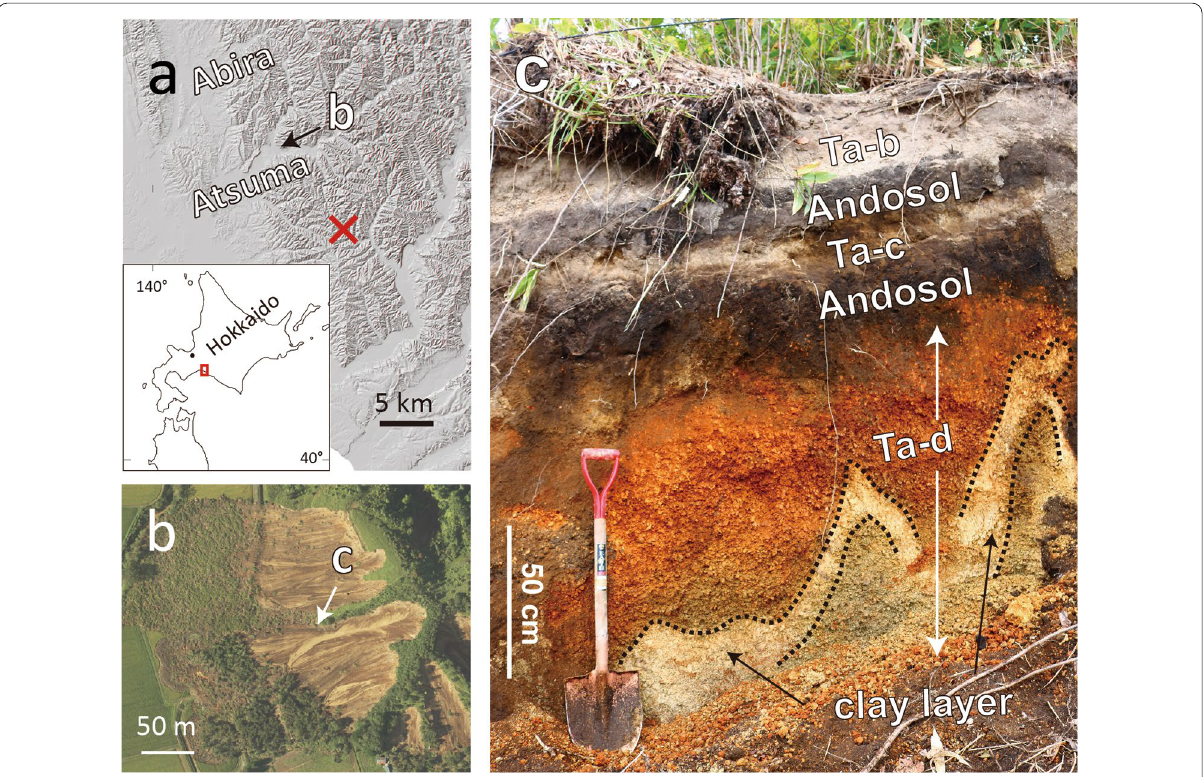
Fig. 1 a Locations of the epicenter of the Eastern Iburi earthquake (red cross) and the studied landslide in the Tomisato district (42.762°N, 141.931°E; black arrow). b Aerial view of the landslide (Geospatial Information Authority of Japan, 2018). c Lateral scarp showing a stratigraphic sequence of volcanoclastic deposits from Tarumae volcano (modified after Kameda et al. 2019). Weathered tephra samples were collected from the clay layer in the Ta-d layer that is in contact with the underlying Neogene sedimentary rock. The clay layer contains 40% halloysite (Kameda